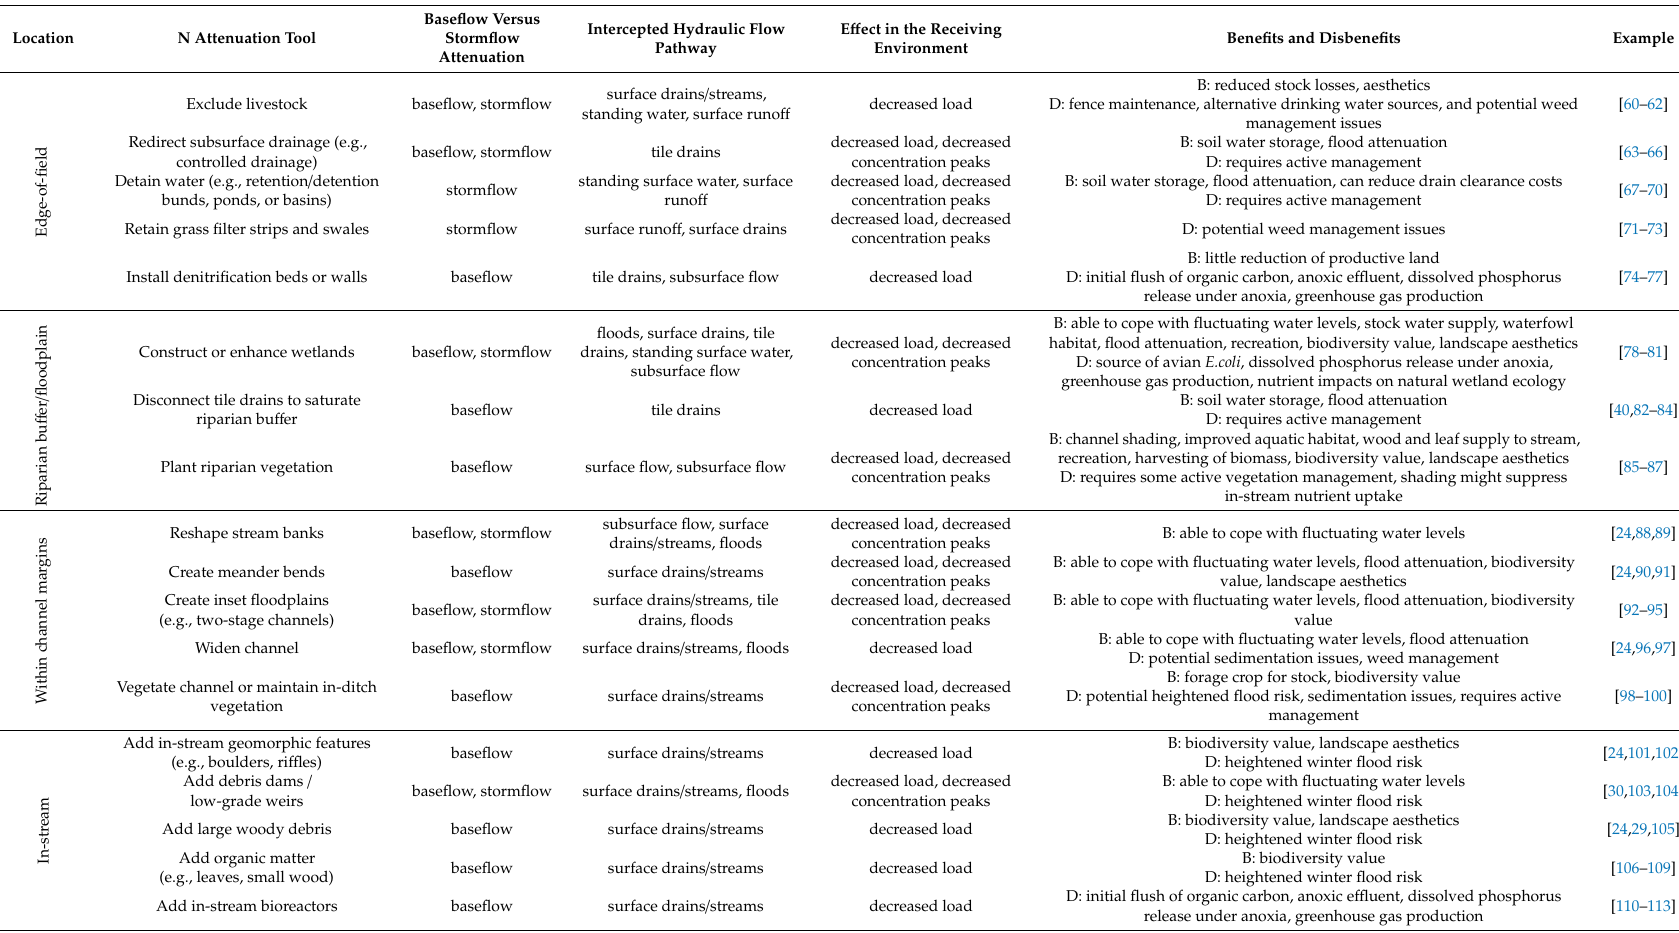
Table 1. Overview of N attenuation tools that can be stacked across multiple locations and scales for small agricultural waterways. Tools are grouped by their location from the edge-of-field to in-stream. Potential benefits (B) and disbenefits (D), and published field study examples are provided.